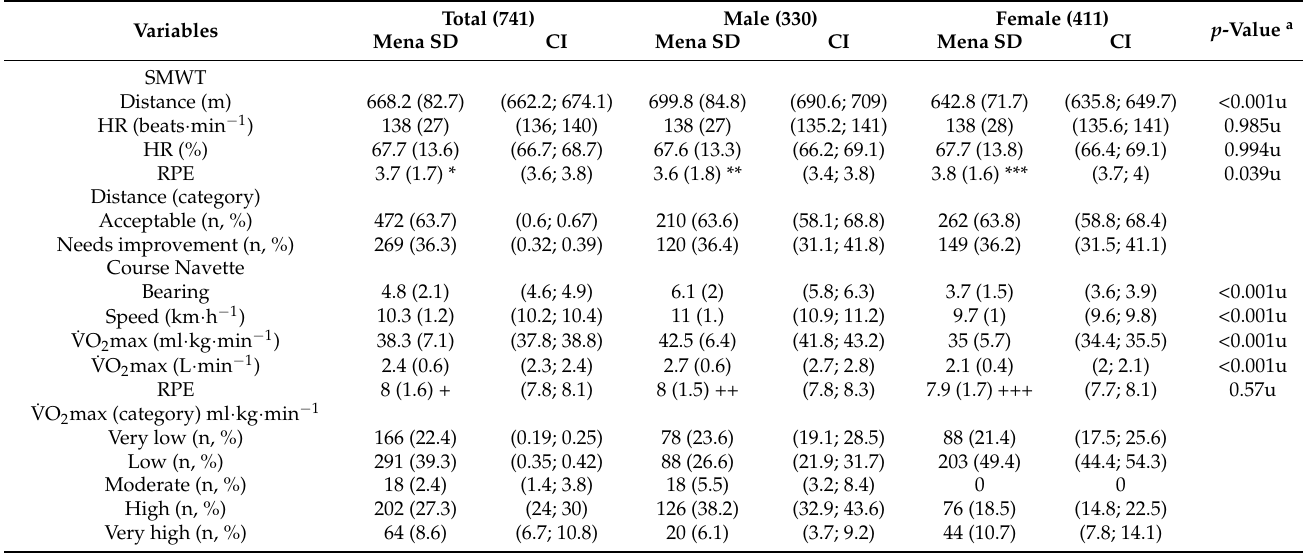
Table 2. Cardiorespiratory fitness in Course Navette and SMWT.